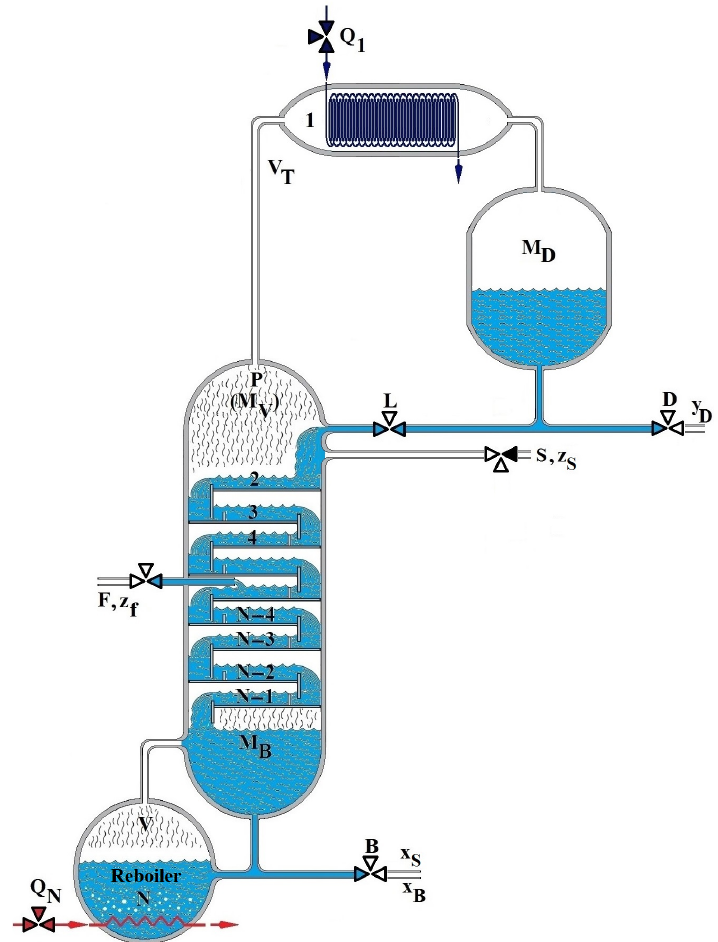
Figure 9. Scheme of the extractive distillation column and its variables.